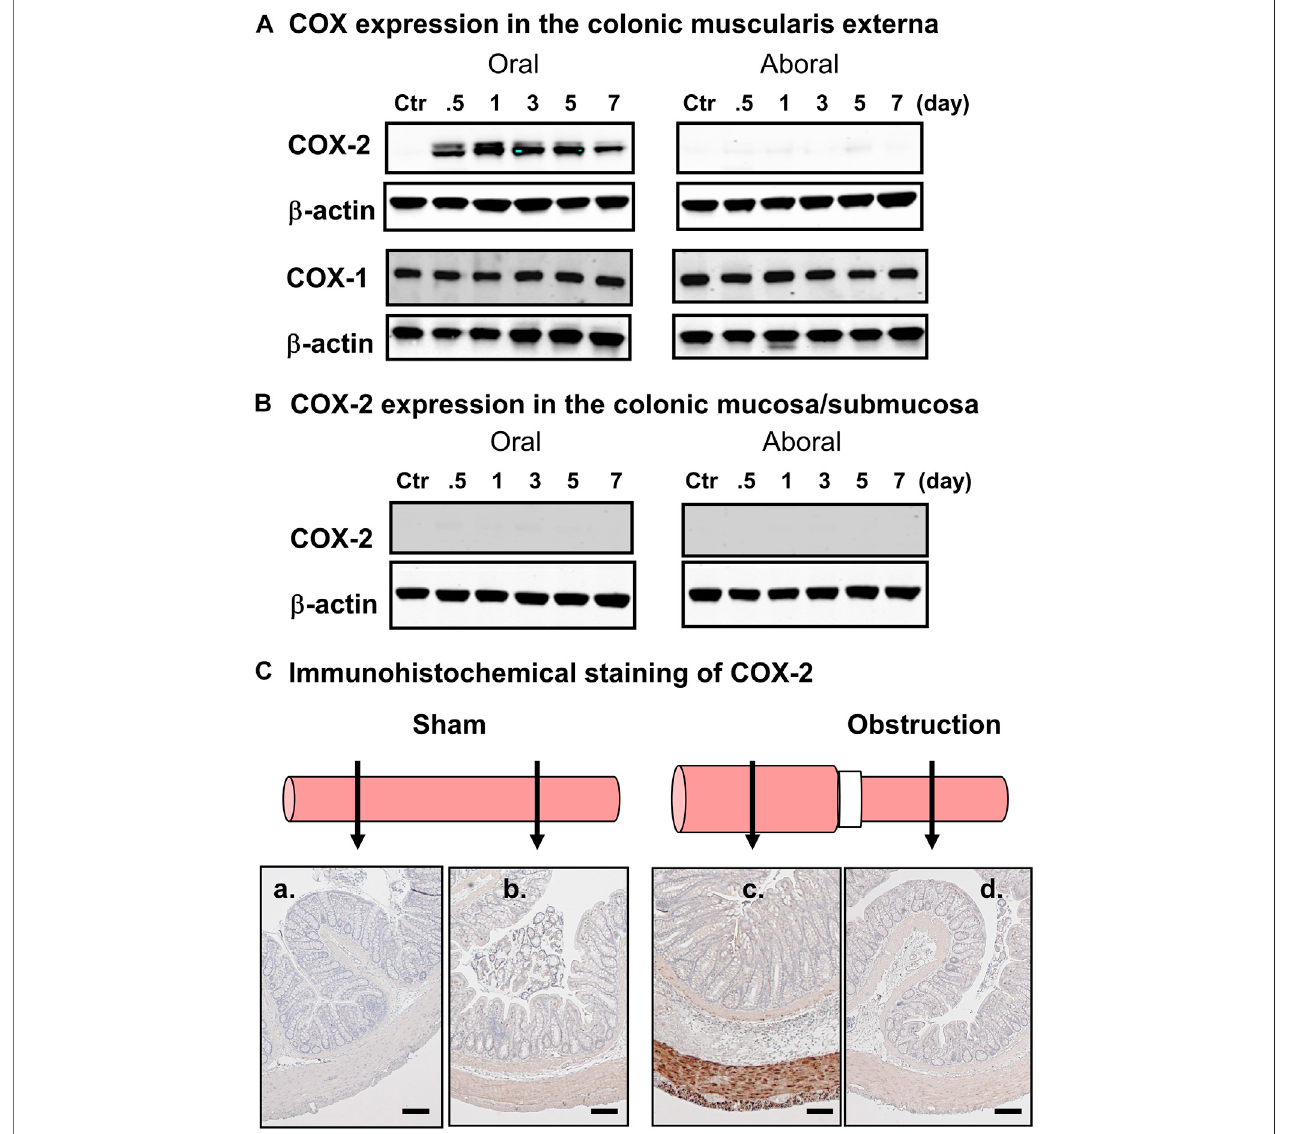
FIGURE 2 | Mechanical stress-induced up-regulation of COX-2 selectively in gut smooth muscle cells. (A) Western blot detected up-regulation of COX-2, but not COX-1, in the colonic muscularis externa in the oral segment, but not aboral segment, in relation to the obstruction band. (B) Western blot did not detect COX-2 expression inthemucosa/submucosalayerinsegmentseitheroraloraboraltotheobstructionband. (C) ImmunohistochemicalstudyofCOX-2expressioninsegments oral (a, c) and aboral (b, d) colon segments in a sham operated rat (a, b) and a rat with obstruction (c, d) for 3 days. The expression of COX-2 (stained in brown) is detected only in smooth muscle cells in the distended oral segment (c). The results shown here are representative of four independent experiments. Calibration bars represent 50 μ m. Some parts of the fi gure are adapted with permission from Figure 1 of Shi (2017).